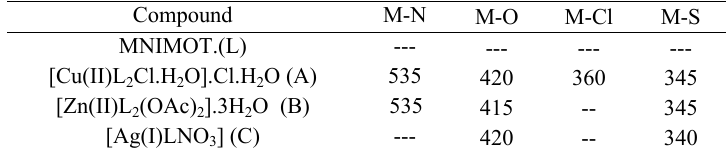
Table 4. IR bands of metal